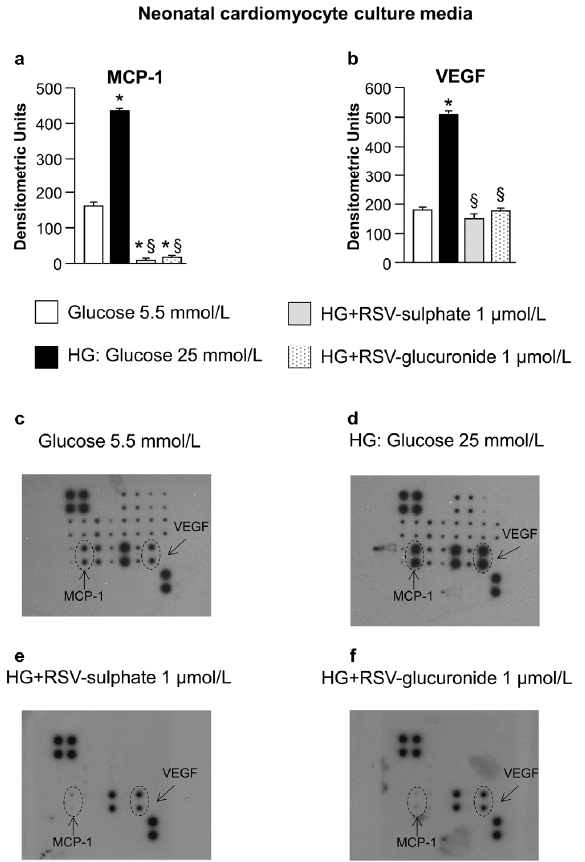
Figure 2. Analysis of neonatal cardiomyocyte culture media. Average values ± SEM of pro ‐ inflammatory cytokines expressed by neonatal cardiomyocytes ( a , b ) cultured in normoglucidic (Glucose 5.5 mmol/L), hyperglucidic (HG, High Glucose: 25 mmol/L) or hyperglucidic + RSV metabolites medium. * p < 0.05 vs. normoglucidic conditions. § p < 0.05 vs. HG conditions (one ‐ way ANOVA, Holm ‐ Šídák post test); Panels ( c – f ) typical images obtained with RayBio Rat Cytokine Antibody Array 1. VEGF: Vascular endothelial growth factor. Other explanations as in Figure 1.